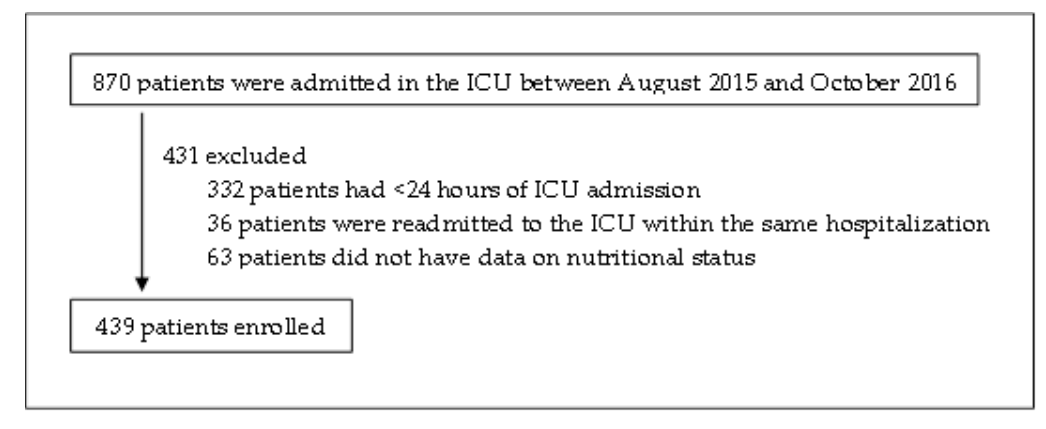
Figure 1. Enrollment of patients. ICU, Intensive Care Unit.